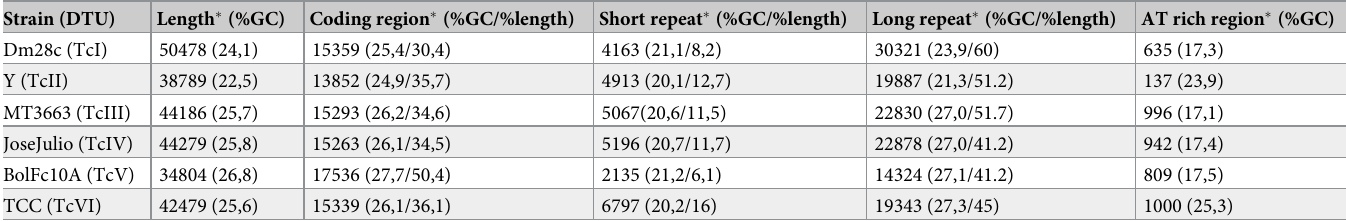
Table 1. Statistics of assembled maxicircles. Length of coding region, AT rich region, short and long repeat region are reported for each strain. ( � ) base pairs. Strain (DTU) Length � (%GC) Coding region � (%GC/%length) Short repeat � (%GC/%length) Long repeat � (%GC/%length) AT rich region � (%GC) Dm28c